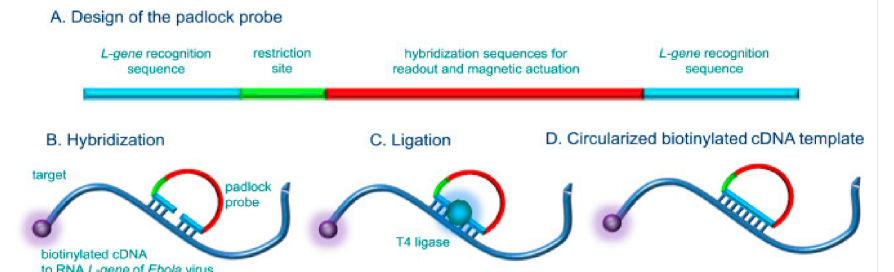
Figure 5. Diagram of padlock probe and its circularization upon hybridizing. ( A ) Padlock probe composition containing two target-complementary sequences (L-gene recognition sequence) con- nected by a linker sequence containing restriction and readout sites. ( B – D ) Hybridization of probe with biotinylated cDNA (mimicking viral EBV L-gene) allowing for ligation using T4 ligase and subsequent circularization. [107] Reused with permission from Elsevier.